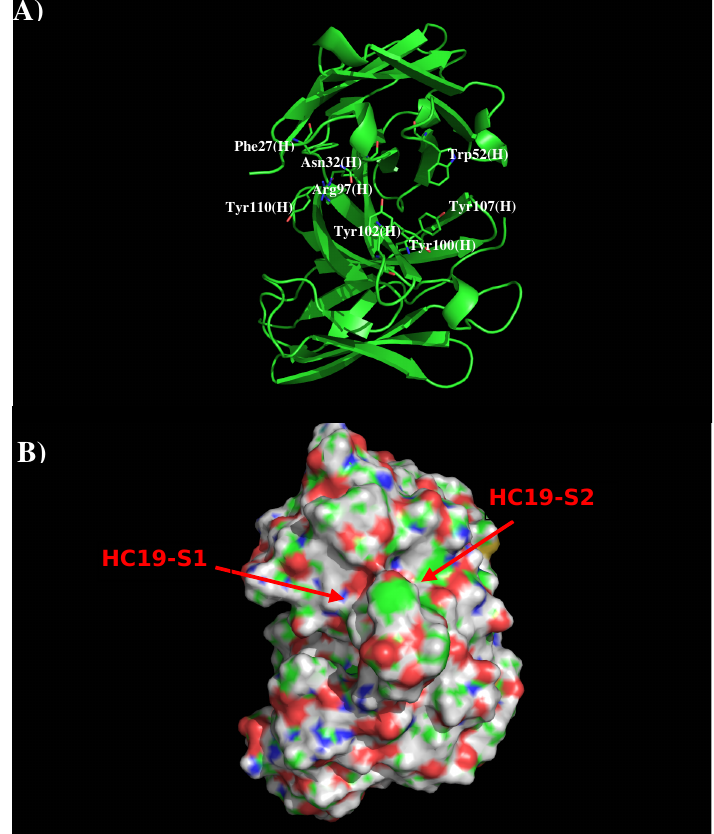
Figure 1. Model structure ( A ) and surface representation ( B ) of antibody HC19. Residues important for the antibody interactions are shown in stick form in ( A ). (L) and (H) denote the L and H chain of the antibody respectively. The figure was prepared using PyMOL